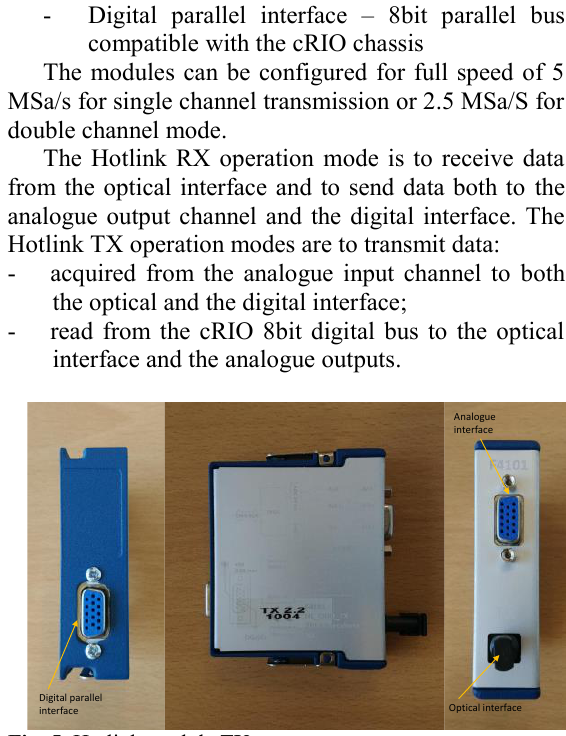
Fig. 5. Hotlink module TX.